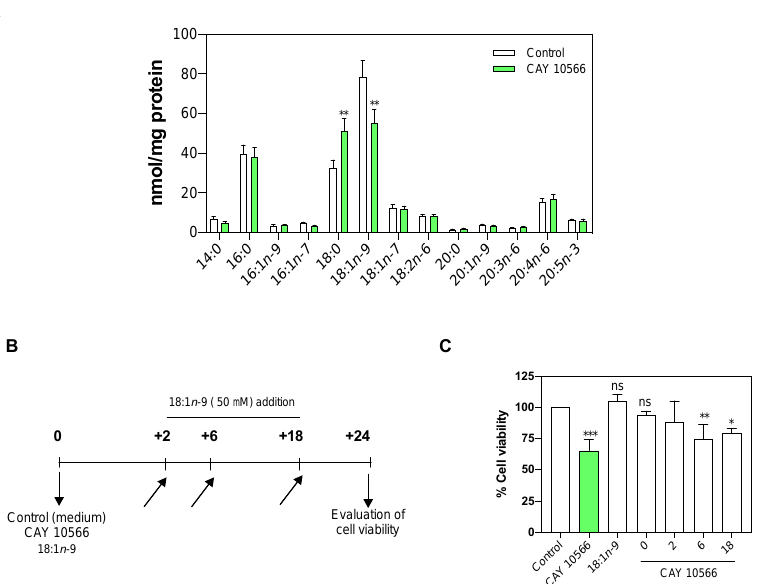
Figure 5. SCD-1 pharmacological inhibition . ( A ) Caki-2 cells were treated with the enzyme inhibitor CAY 10566 (3 µM) for 24 h. ( B ) Experimental design used in SCD-1 inhibition (slanted arrows indicate the addition of 18:1 n -9 at different times). ( C ) Cell viability was measured with the CellTiter 96 ® kit. In all cases, the cells were cultured with 1% fetal bovine serum. Data are expressed as the means ± SEM and are representative of three independent experiments. * p < 0.05, ** p < 0.01 and *** p < 0.001, significantly different from the control.